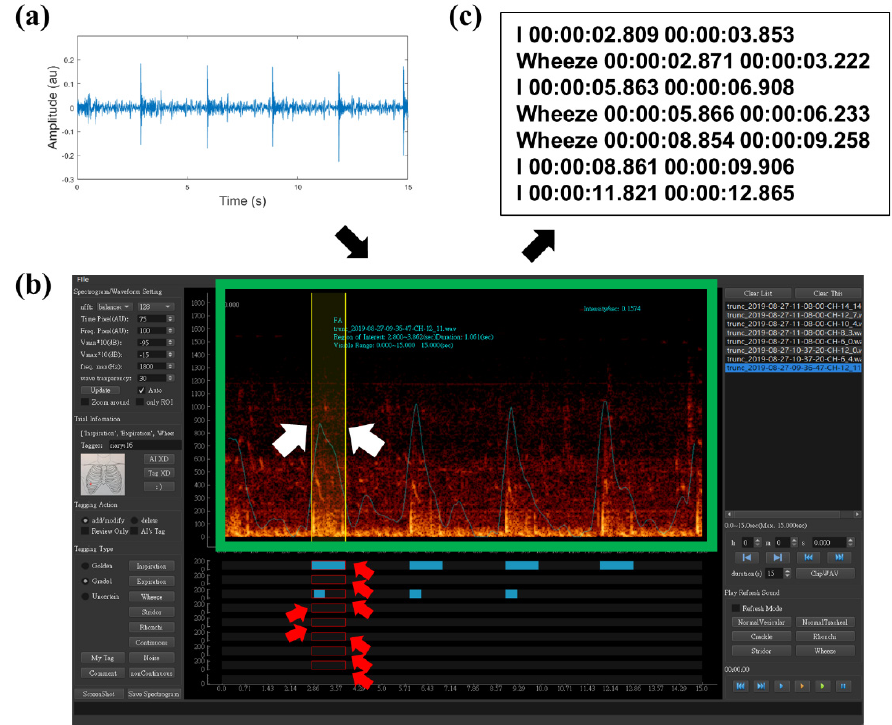
Figure 2. Labeling process. ( a ) Raw signal of a lung sound recording. ( b ) Labeling software. ( c ) Out- put in a label file. In ( b ), the green square represents the spectrogram, the yellow lines indicated by the white arrows represent the boundaries of an ROI (the transparent yellow patch), and the red arrows indicate areas on different label tracks of which start and end times bounded by the ROI; when a labeler clicks on one of them, a corresponding label is generated.